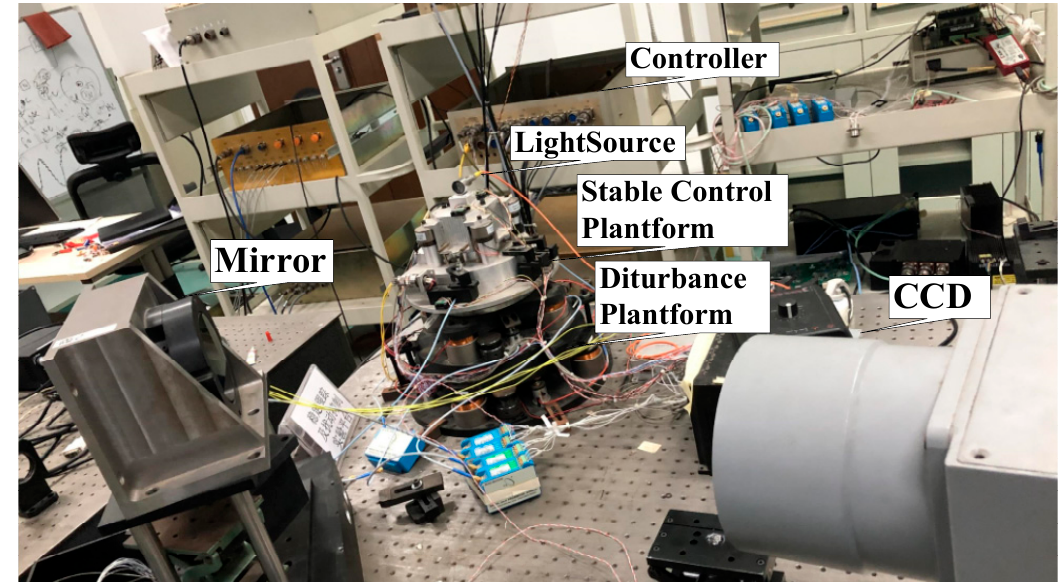
Figure 8. Experimental Platform.